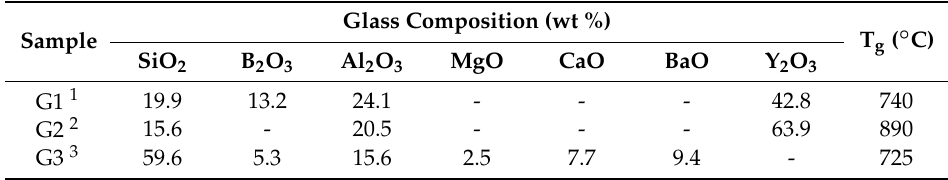
Table 1. Compositions and glass transition temperatures of the glasses